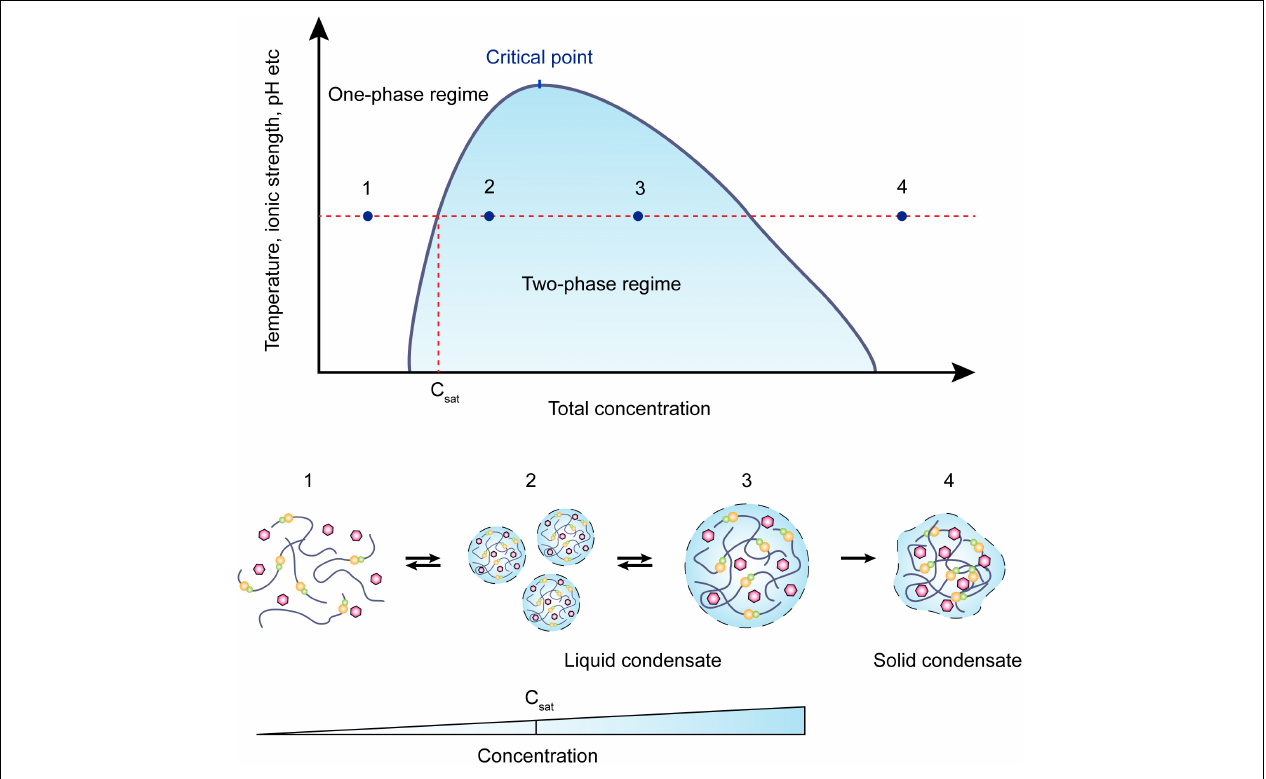
FIGURE 1 | Schematic view of a phase diagram. Phase separation is a function of molecular concentration under environmental conditions such as temperature, ionic strength, pH, etc. At a concentration below Csat , the system remains in the one-phase regime. As the concentration increases, two-phase regimes will coexist in the system, and the required concentration is effected by the environmental change as represented in the y-axis. Within the coexistence line (black), molecules often condense into smaller droplets and fuse into bigger droplets to lower the surface tension. These processes are usually reversible. When the concentration continuously increases, the droplets may irreversibly turn into gel-like or solid